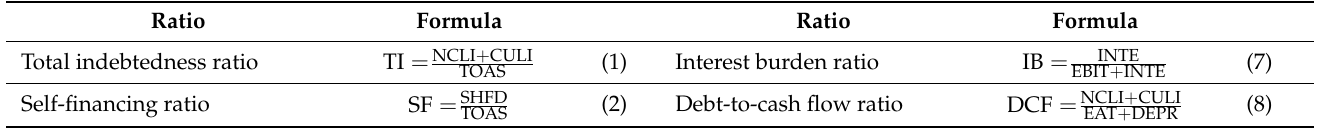
Table 2. Summarized formulas of indebtedness